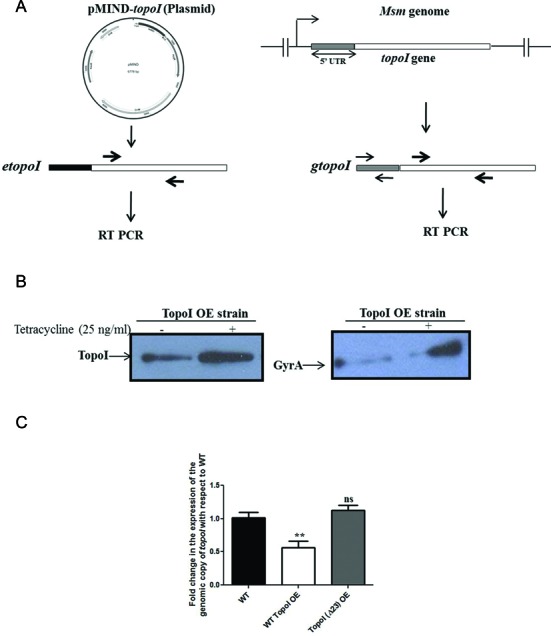
Reduced expression of TopoI upon chromosome relaxation. The chromosome relaxation was carried out by ectopic overexpression of M. smegmatis TopoI using tetracycline inducible system. The exponential phase M. smegmatis cells were treated with the tetracycline (25 ng/ml) for 6 h and the expression of TopoI and DNA gyrase was monitored both at protein as well as RNA level. (A) Schematic for the discriminatory qRT PCR. The 5′ UTR of the ectopically expressed topoI (etopoI) and genomic copy of topoI (gtopoI) were different. The primers specific for gtopoI were used to determine the alteration in the expression of gtopoI upon TopoI overexpression (to cause chromosome relaxation). (B) Immunoblot analysis of TopoI and gyrase expression upon induction with the tetracycline. The increased overexpression of GyrA upon TopoI overexpression indicates the chromosome relaxation (RST). (C) Measurement of the genomic topoI transcript abundance in the cells upon overexpression of TopoI by discriminatory qRT PCR analysis. The fold change is expression represents the expression of topoI transcripts upon tetracycline induction normalized with the uninduced RNA samples. topoI (ORF) indicates the expression of total topoI transcripts; gtopoI and etopoI represents the expression of genomic copy and plasmid copy of topoI transcripts, respectively. The error bars represents the SD obtained from three independent experiments. *P < 0.01, **P < 0.001, ns: not significant (P > 0.1).